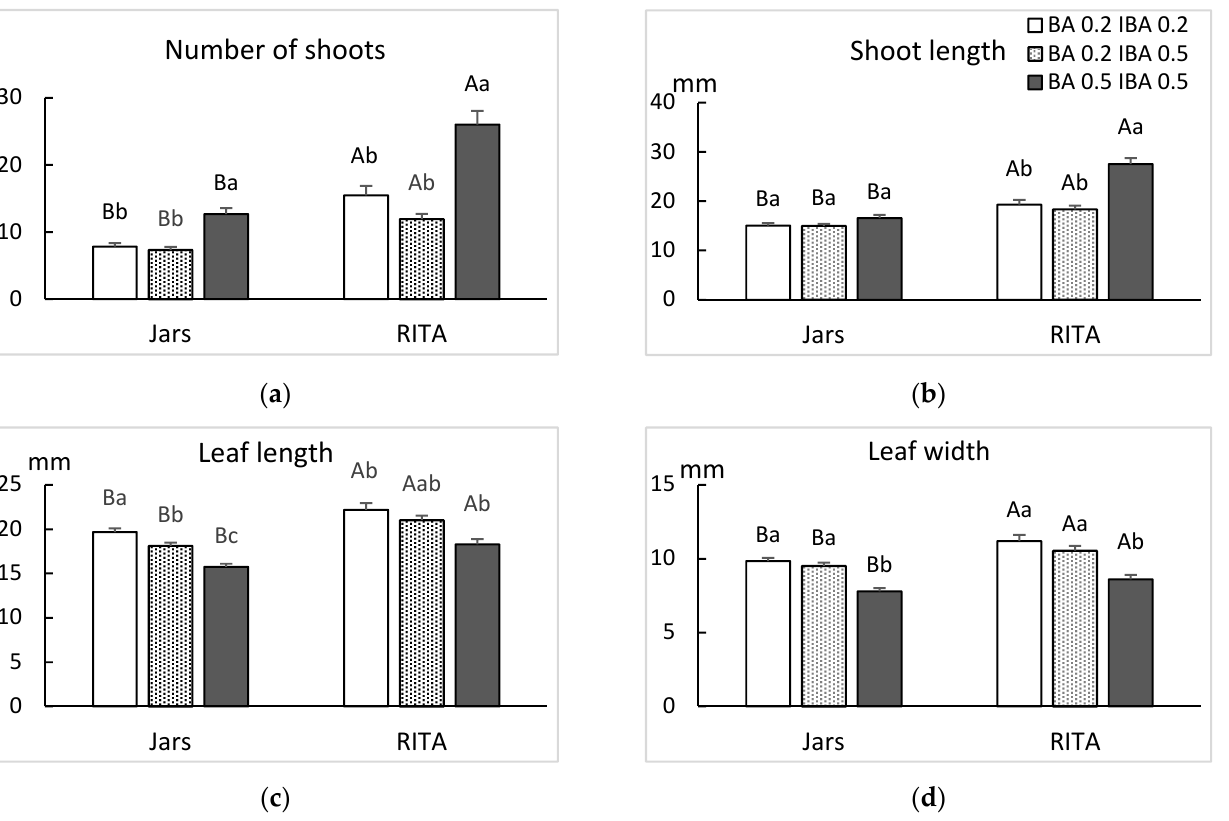
Figure 5. Effect of the hormonal composition of the media and the culture system on the growth of the plum genotype CFN. ( a ) Number of shoots, ( b ) shoot length, ( c ) length and ( d ) width of the largest leaf. Different uppercase letters indicate significant differences between culture system and different lowercase letters indicate significant differences between the hormonal treatments ( p < 0.05).